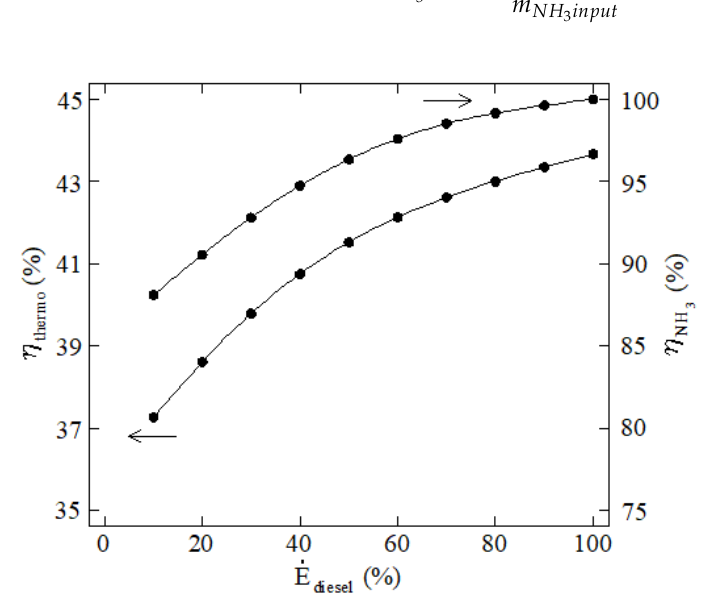
Figure 9. Thermodynamic and ammonia utilization efficiencies against the power contribution from diesel fuel.